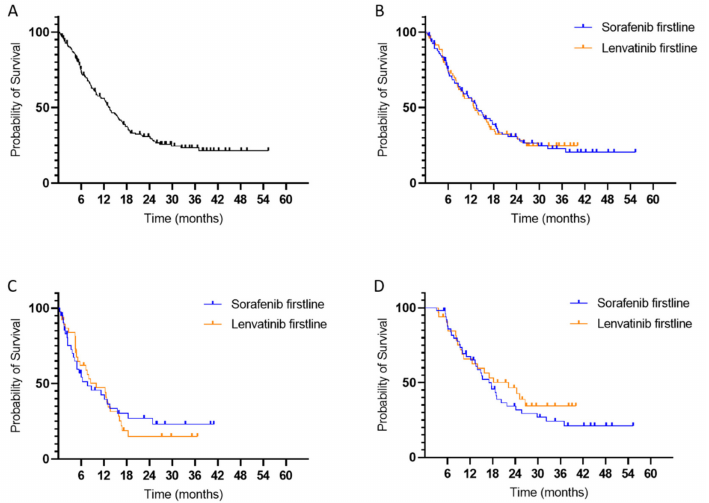
Figure 2. Kaplan-Meier curve of the median overall survival (mOS) from first-line therapy. ( A ) Whole cohort (mOS 410 days); ( B ) sorafenib vs. lenvatinib (mOS sorafenib 411 days; mOS lenvatinib 386 days; p value ns); ( C ) patients with only 1 systemic therapy and sorafenib or lenvatinib as first-line therapy (mOS sorafenib 233 days; mOS lenvatinib 302 days; p value ns); ( D ): patients with >1 systemic therapy and sorafenib or lenvatinib as first-line therapy (mOS sorafenib 536 days; mOS lenvatinib 676 days; p value ns).